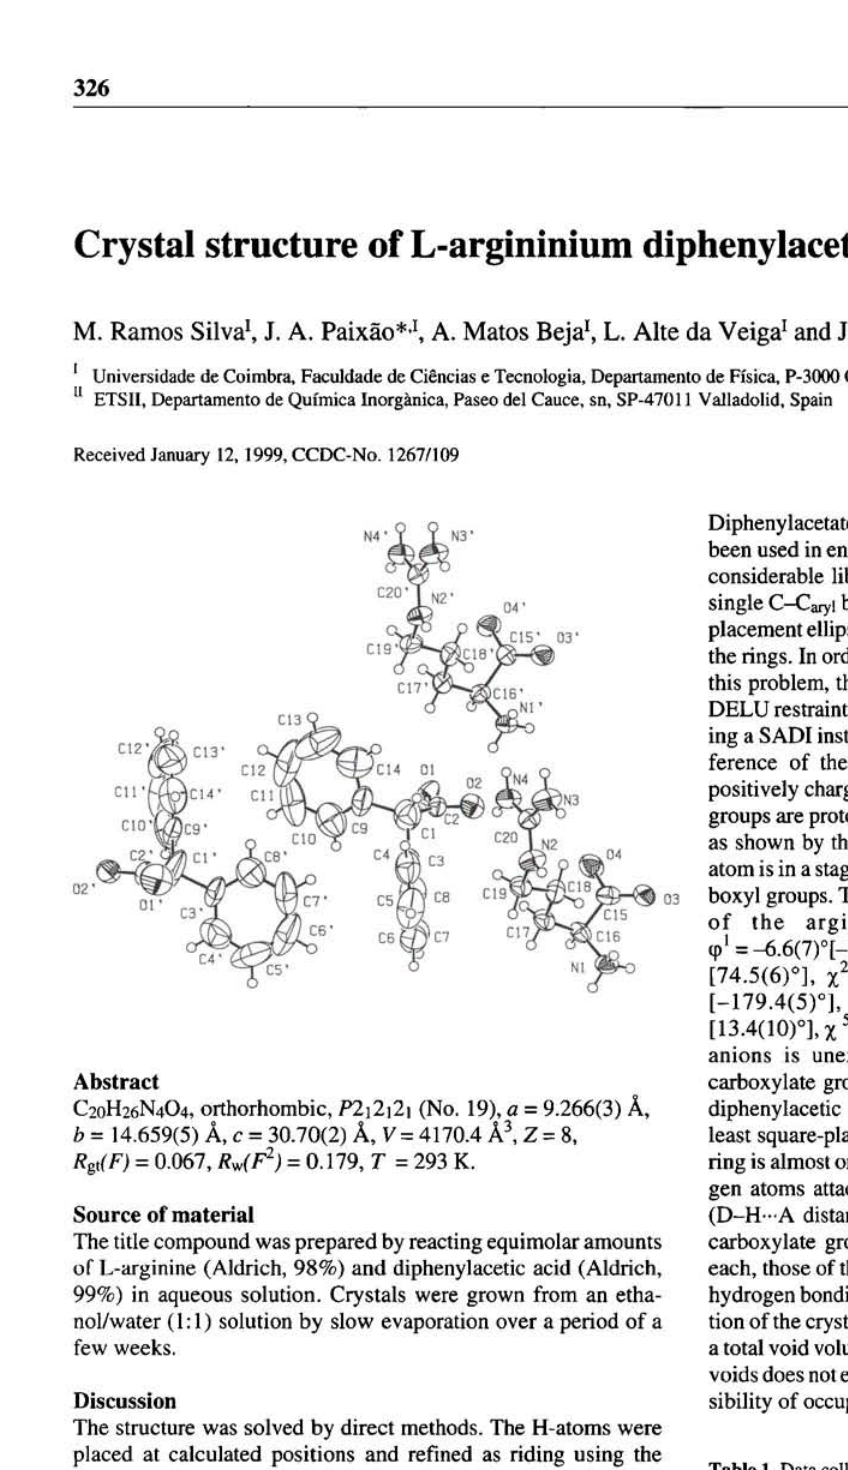
Table 1. Data collection and